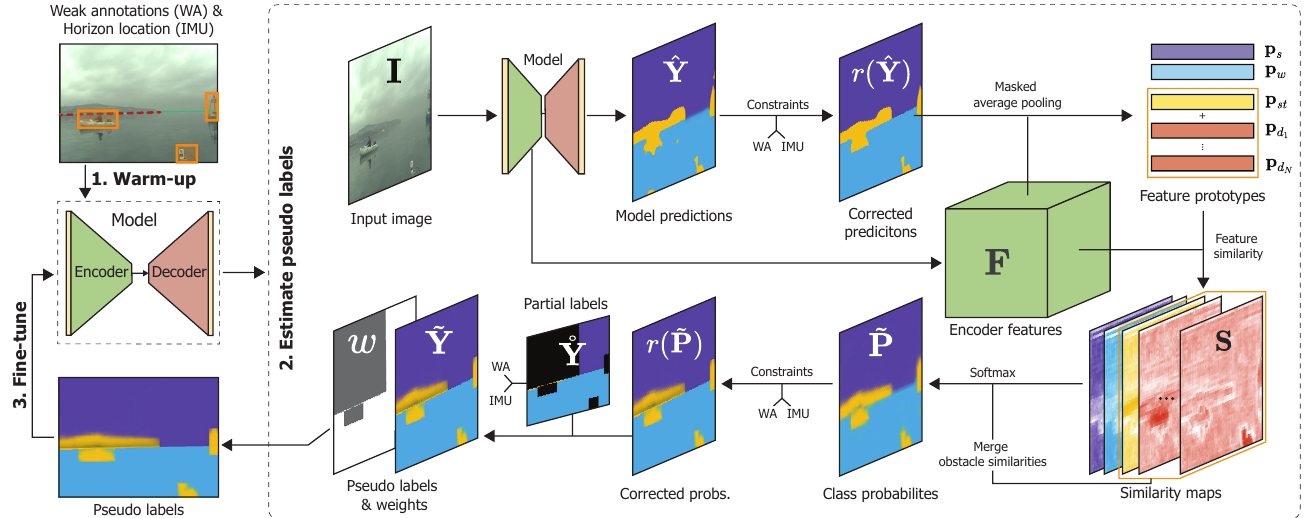
Figure 2. The proposed scaffolding approach SLR is comprised of three steps. (1) The model is warmed-up using object-wise and global objectives derived from weak annotations and IMU. (2) The learned encoder features and model predictions are used to estimate the pseudo labels. (3) The network is fine-tuned with the estimated pseudo